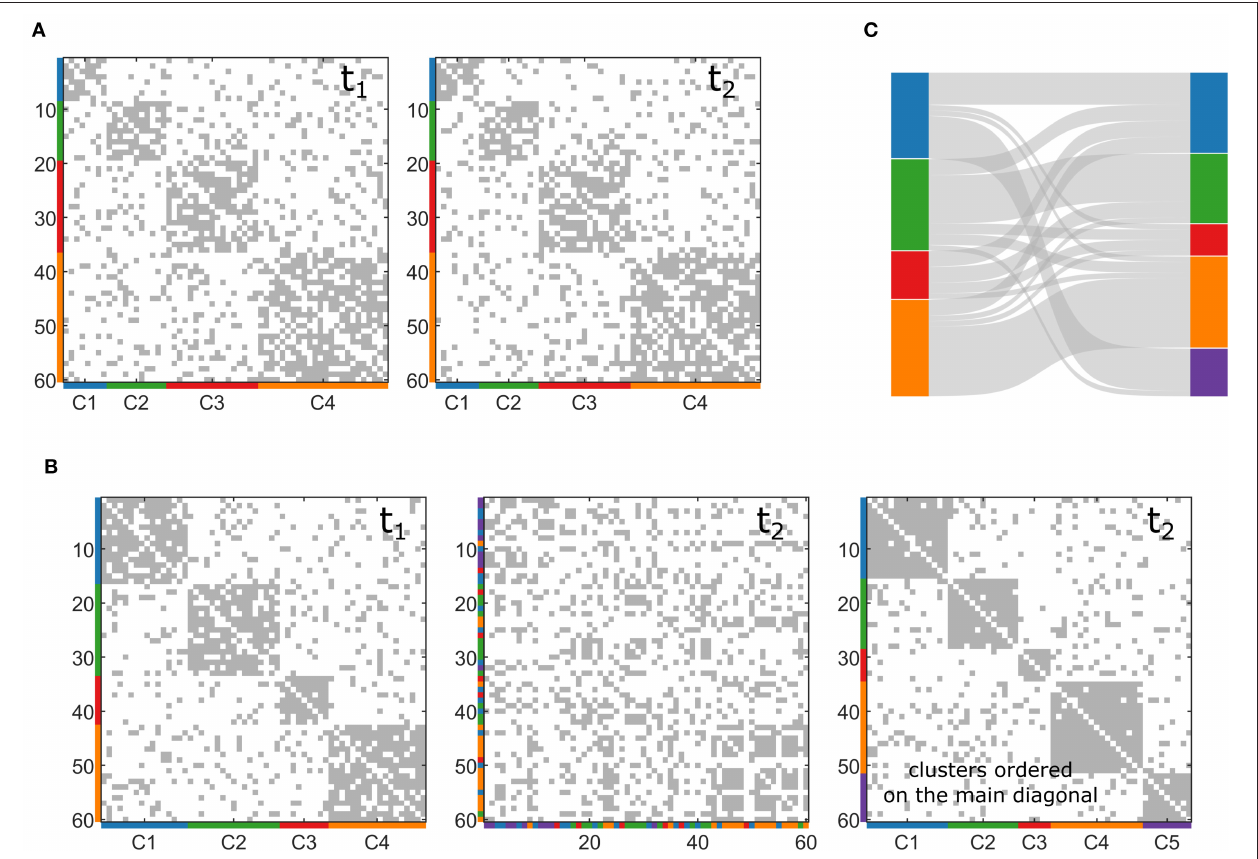
FIGURE 1 | Examples of synthetic multilayer networks generated through the toolbox. (A) Two snapshots (t 1 and t 2 ) of a multilayer network with stationary community structure. (B) Two snapshots (t 1 and t 2 ) of a multilayer network with evolving community structure. In the second t 2 , the nodes are re-ordered to represent clusters on the main diagonal. (C) Sankey diagram of the network generated in (B)